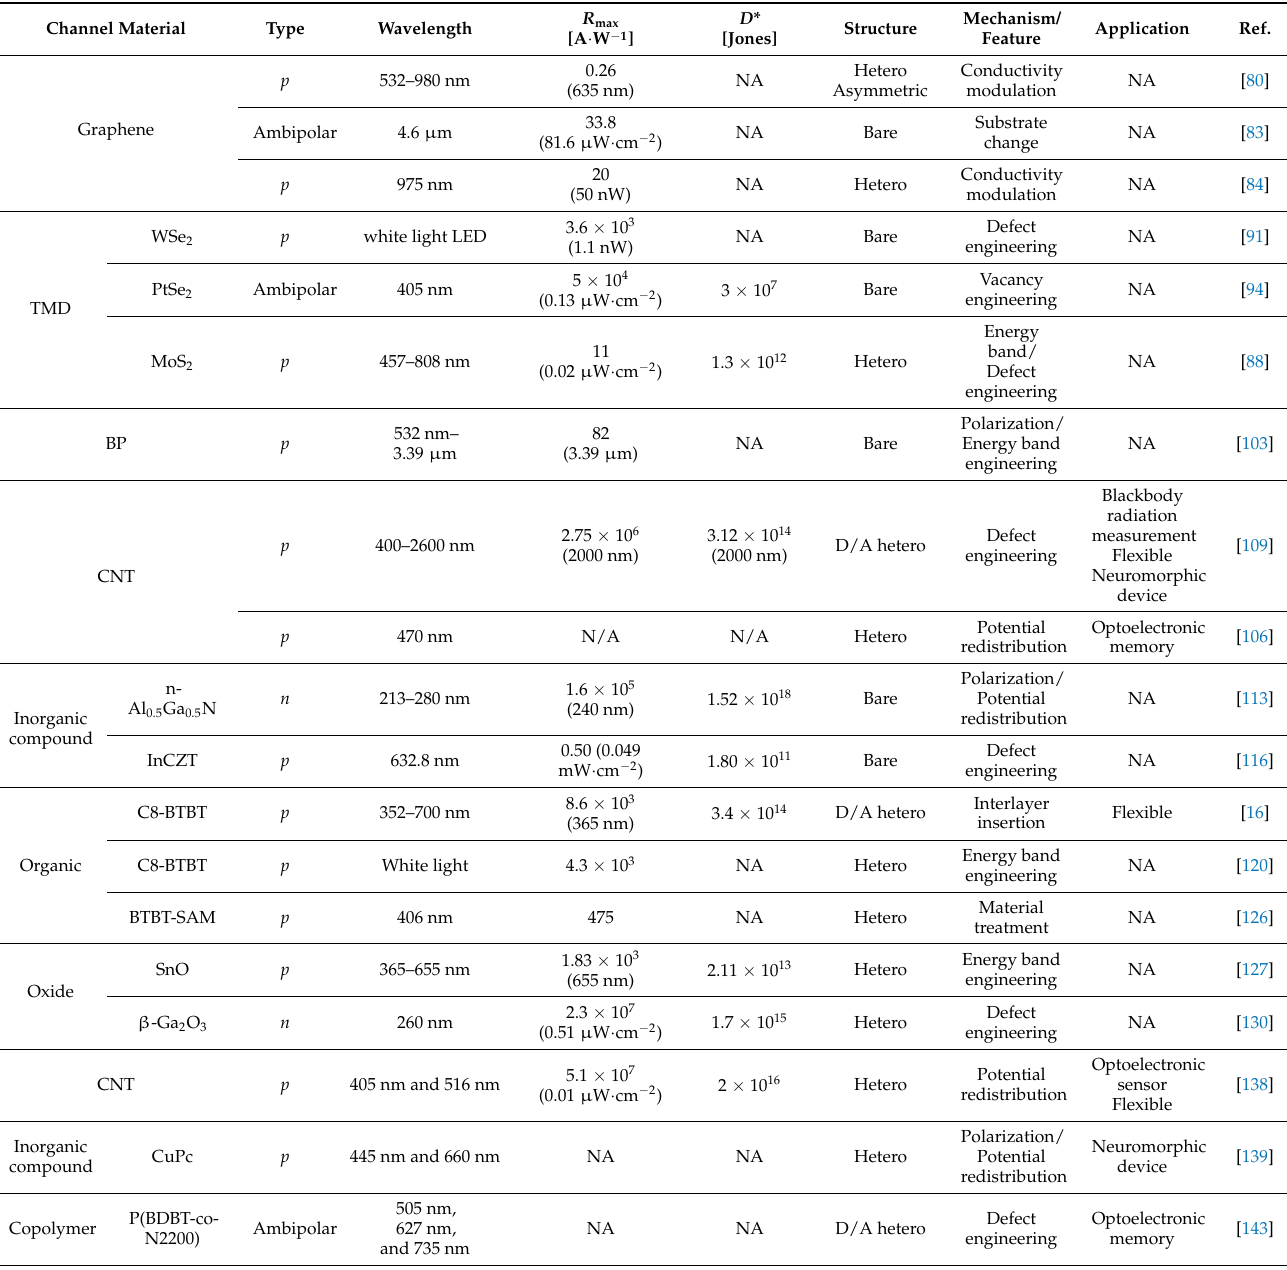
Table 2. Various active channel materials for the photodetection